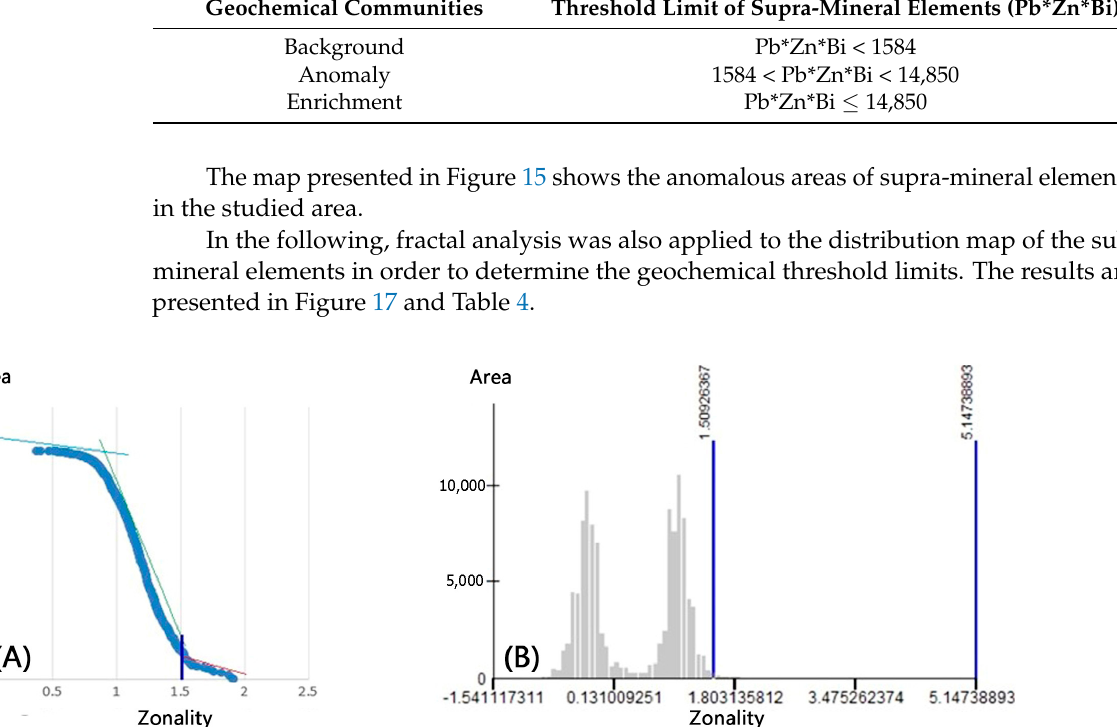
Figure 17. ( A ) Multifractal diagram of sub-mineral elements (Log (Ag*Cu*Mo) versus Log (area) for stream sediment samples); ( B ) Histogram of the calculated areas. According to the threshold limits of geochemical communities for sub-mineral ele- ments, a map of the anomaly community is shown in Figure 18.